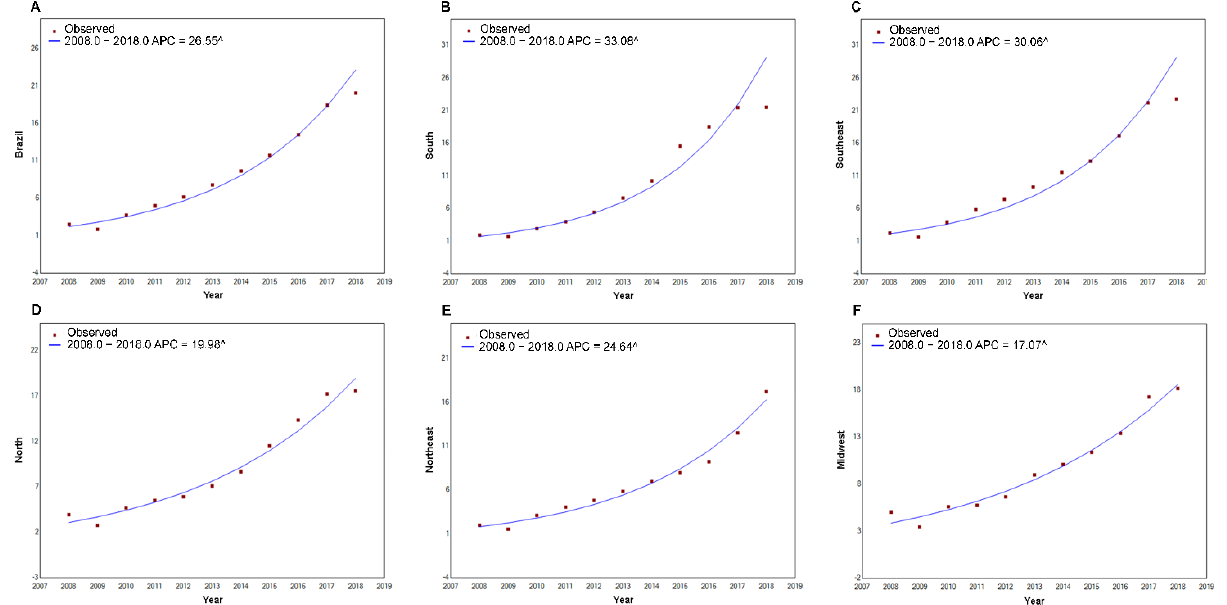
Figure 2. Time series of gestational syphilis detection rate in Brazil ( A ) and by region (South ( B ), Southeast ( C ), North ( D ), Northeast ( E ), and Midwest ( F )), according to the Joinpoints model. Brazil, 2008 to 2018. ^ Indicates that the annual percent change is significant. (APC = 26.55; 95%CI: 22.1 to 31.2). The South and Midwest regions presented the highest (APC = 33.08; 95%CI: 28.1 to 38.2) and lowest APC (APC = 17.07; 95%CI: 13.6 to 20.6), respectively (Figure 2). The APC in the Southeast (APC = 30.06; 95%CI: 23.5 to 37.0), Northeast (APC = 24.64; 95%CI: 20.4 to 29.0), and North (APC = 19.98; 95%CI: 16.3 to 23.8) indicated an increasing trend with no inflection points during the analyzed period (Figure